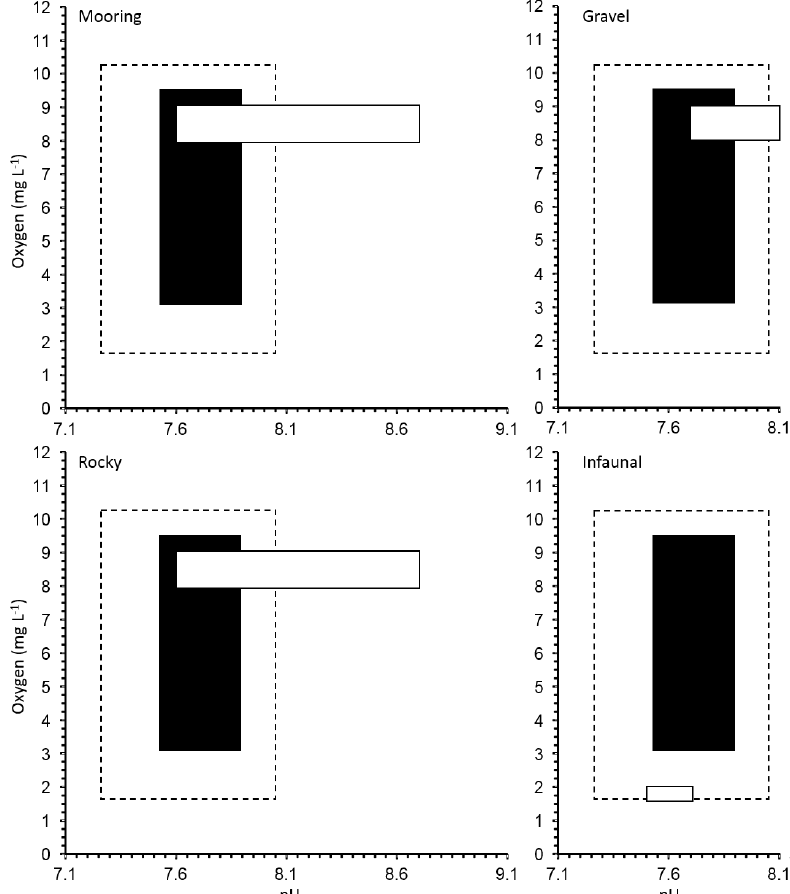
Figure 3. Realized oxygen concentration and pH conditions for a manipulation experiment for 11 invertebrate species from four different natural habitats in the Gullmar Fjord: gravel, infaunal, mooring and rocky. Average and extreme (maximum and minimum) O 2 and pH conditions during experimental exposure are shown in black and with dotted line, respectively. The natural O 2 and pH conditions expected for each habitat are shown in the white